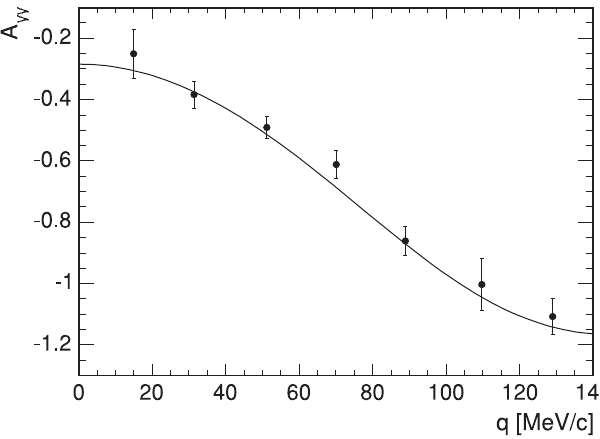
FIG. 11. Values of the tensor analyzing power A for the ~dp ! (cid:1) pp (cid:2) n reaction at 1170 MeV for E The curve corresponds to the predictions of the impulse approxi- mation of Ref. [43], with input amplitudes taken from Refs.